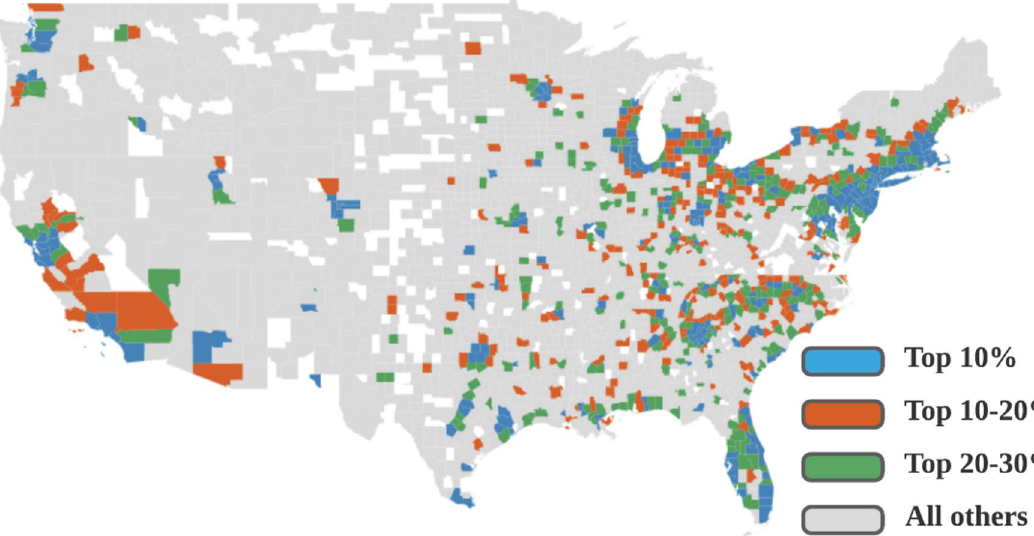
Figure 2. Spatial visualization of studied 2,787 counties with different population densities. Blue: counties with top 10% population density. Orange: counties with top 10–20% population densities. Green: counties with 20–30% population densities. Gray: all other